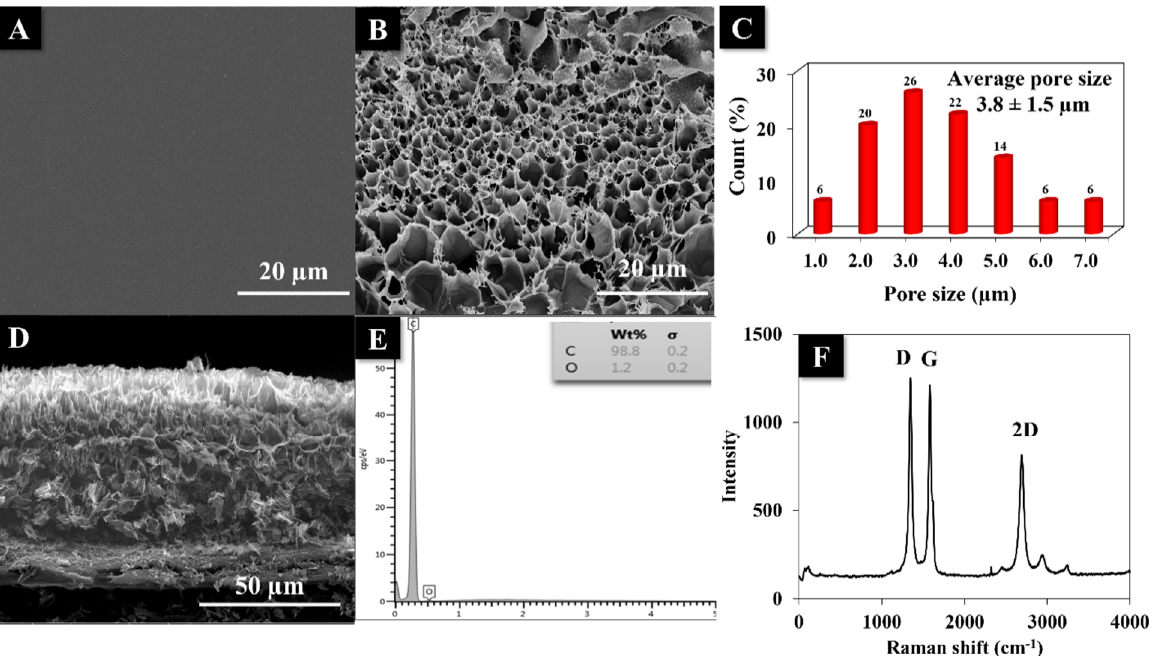
Figure 4. SEM images show Kapton tape before ( A ) and after ( B ) the laser scribing process. ( C ) An average pore size of the porous graphene structure. ( D ) Cross-sectional view of the LI-PGr electrode. ( E ) EDX spectrum and ( F ) Raman spectrum of the LI-PGr electrode. ( E ) EDX spectrum and ( F ) Raman spectrum of the LI-PGr